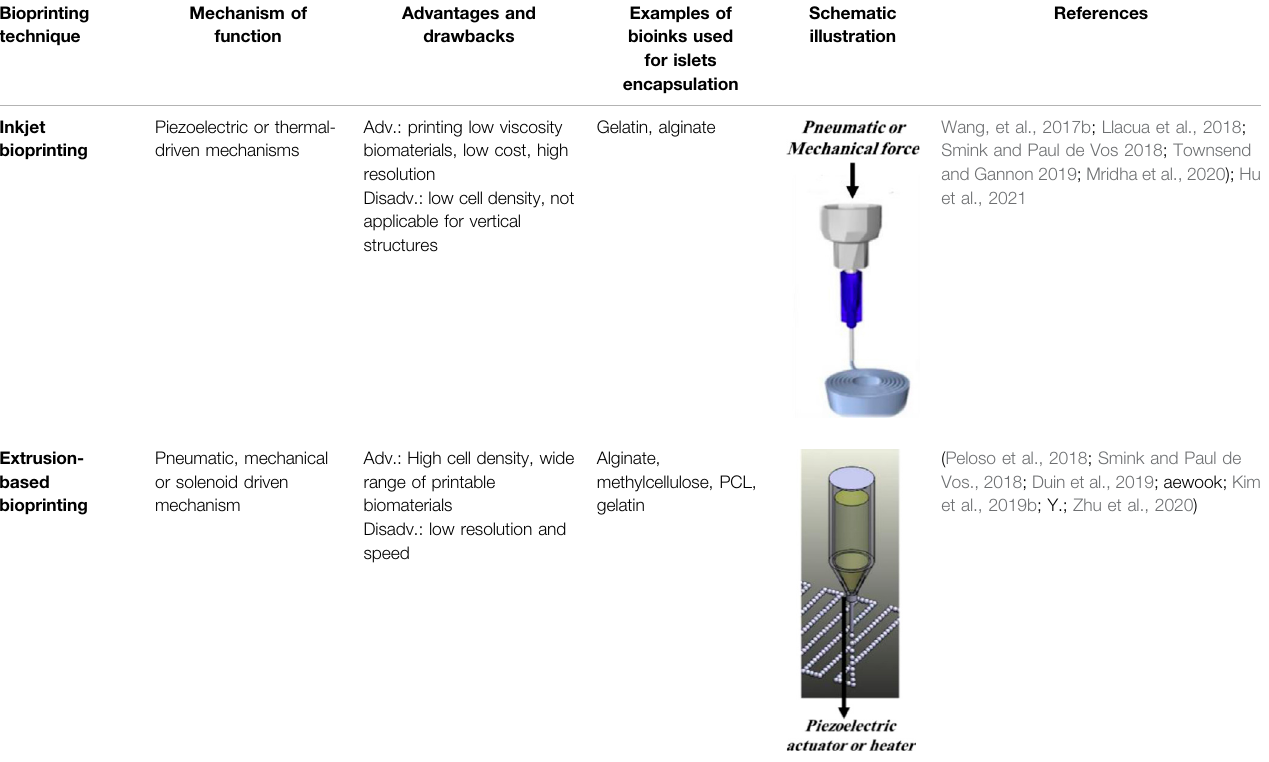
TABLE 1 | A different methods of 3D bioprinting, along with their corresponding advantages and disadvantages, utilized for islet